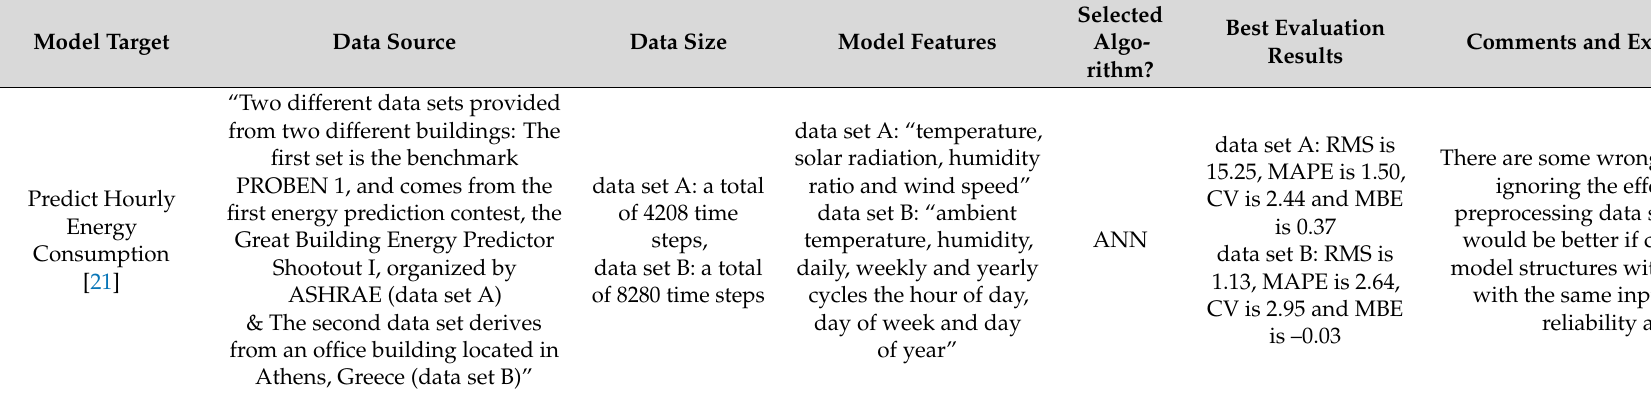
Table 2. The details of the reviewed papers and the comments that result from comparison with the proposed ML